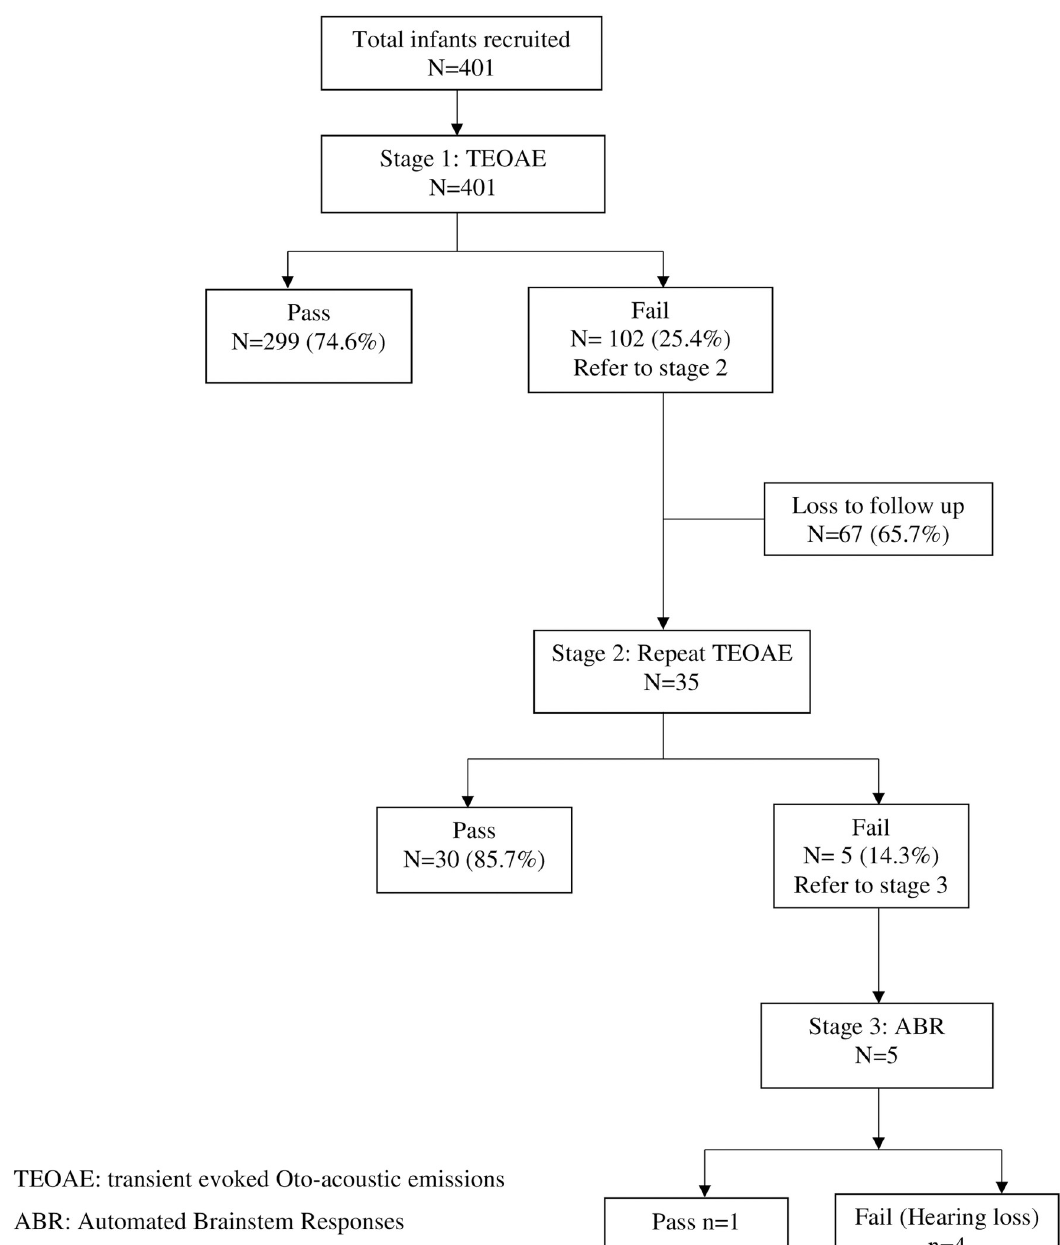
Fig 1. A summary of results of infant hearing screening using TEOAE and ABR